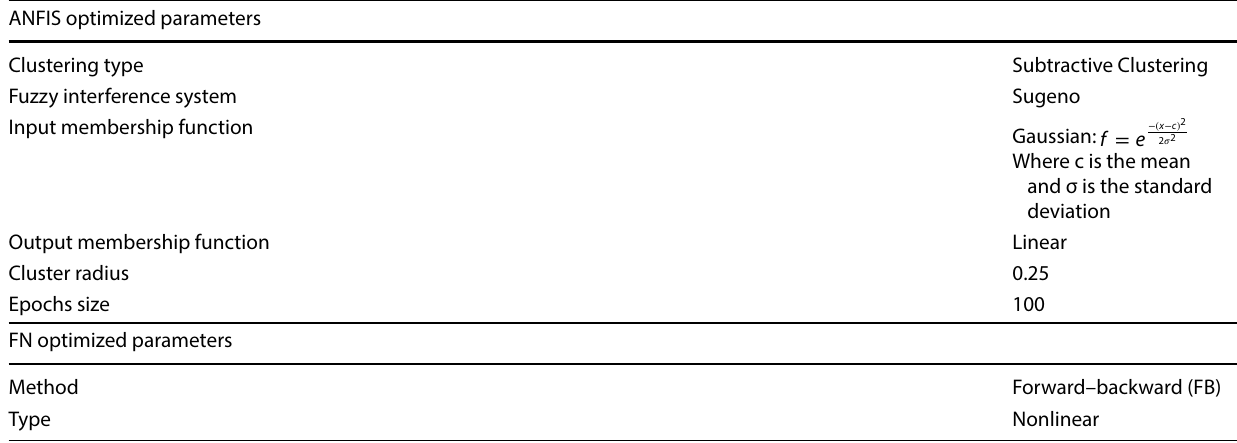
Table 4 Optimized parameters of the AI algorithms ANFIS optimized